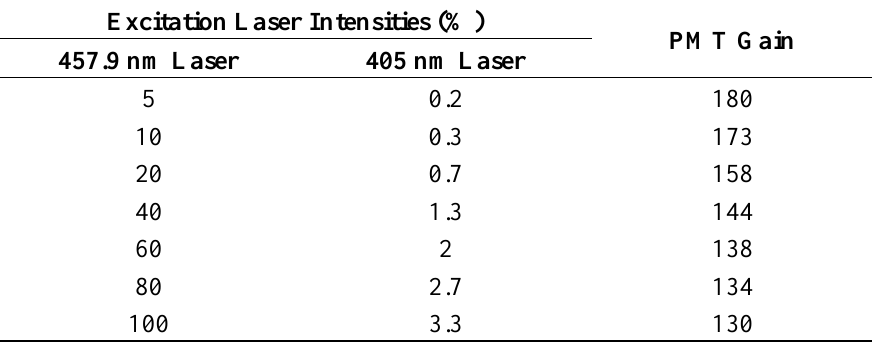
Table 1. At each setting of 457.9 nm excitation, the other laser intensity was changed, such that the ratio between the two laser intensities remains the same. Photomultiplier tube (PMT) gain was adjusted accordingly to utilize the complete dynamic